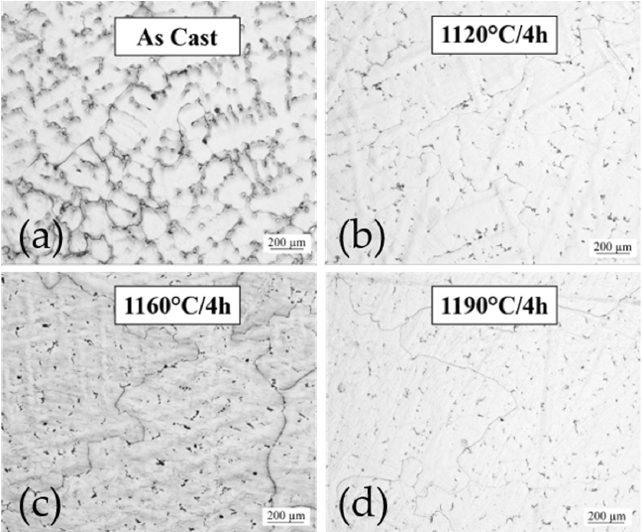
Figure 2. Optical images showing base-metal segregation extent in four conditions: ( a ) As cast, and at ( b ) 1120 °C/4 h, ( c ) 1160 °C/4 h, and ( d ) 1190 °C/4 h.